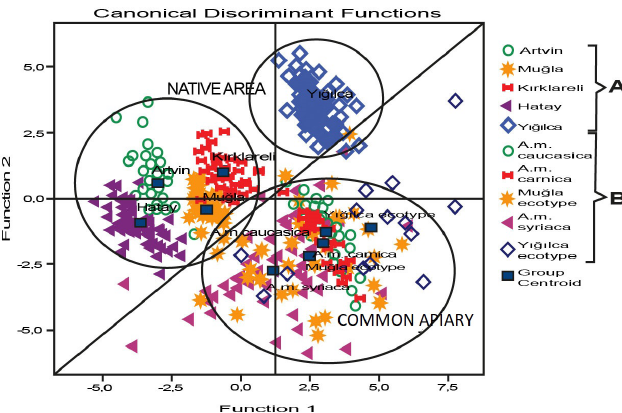
Fig 6. Two dimensional clustering by Discriminant Function Analysis of Colony Means of honeybee subspecies from 5 isolated native area, Artvin and Ardahan ( A. m. caucasica ), Kirklareli ( A. m. carnica ), Muğla (Muğla ecotype of A. m. anatoliaca ), Hatay ( A. m. syriaca ), Düzce (Yığılca ecotype of A. m. anatoliaca ) and common apiary ( A. m. caucasica, A. m. syriaca, A. m. carnica , Mugla and Yigilca ecotype of A. m. anatoliaca ). A: isolated native area, B: common apiary.